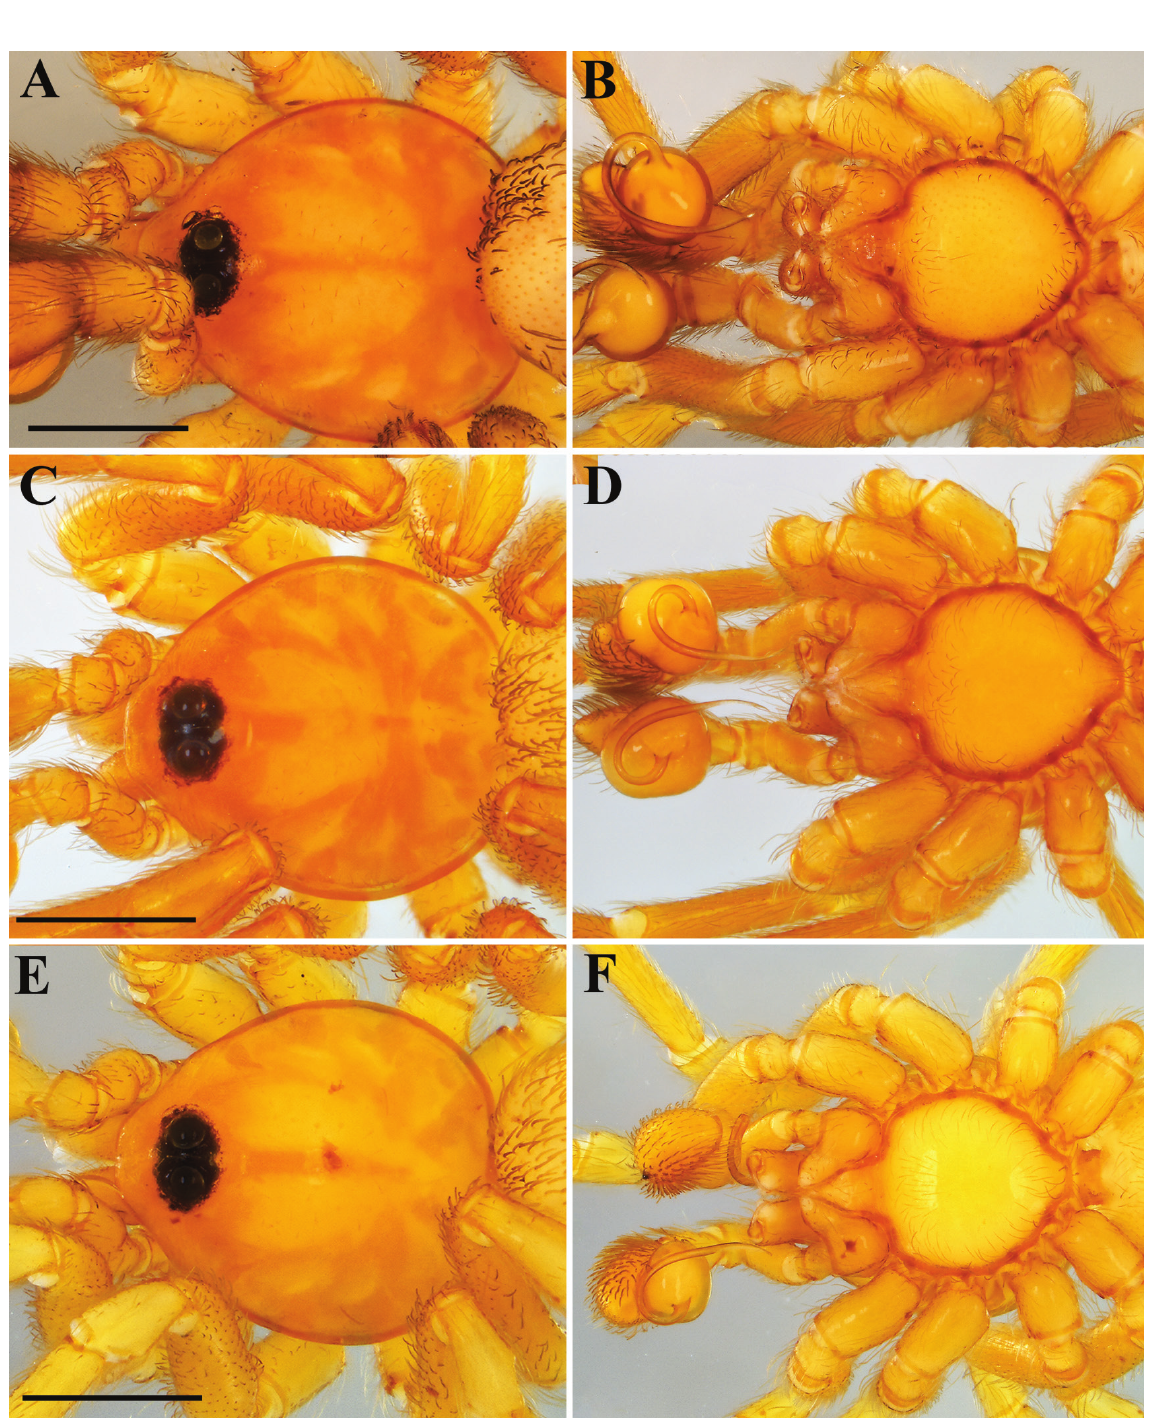
Fig. 5. A – B . Caponina alejandroi sp. nov., ♂, holotype (IAvH-I 3747). A . Prosoma, dorsal view. B . Prosoma, ventral view. – C – D . Caponina bochalema sp. nov., ♂, holotype (IAvH-I 3757). C . Prosoma, dorsal view. D . Prosoma, ventral view. – E – F . Caponina huila sp. nov., ♂, holotype (IAvH-I 3761). E . Prosoma, dorsal view. F . Prosoma, ventral view. Scale bars = 1.5